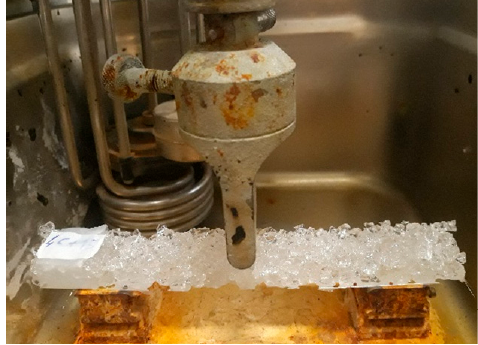
Figure 6. Three-point bending test.